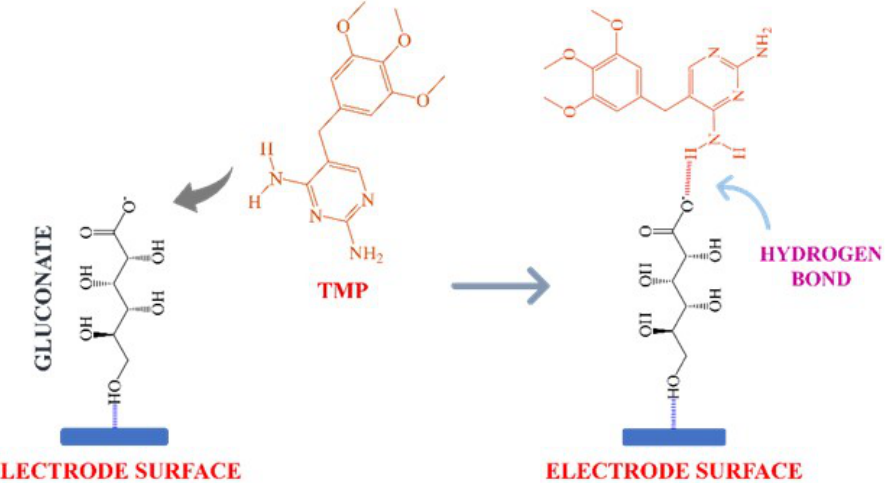
Scheme 2. Probable electrooxidation mechanism of TMP at